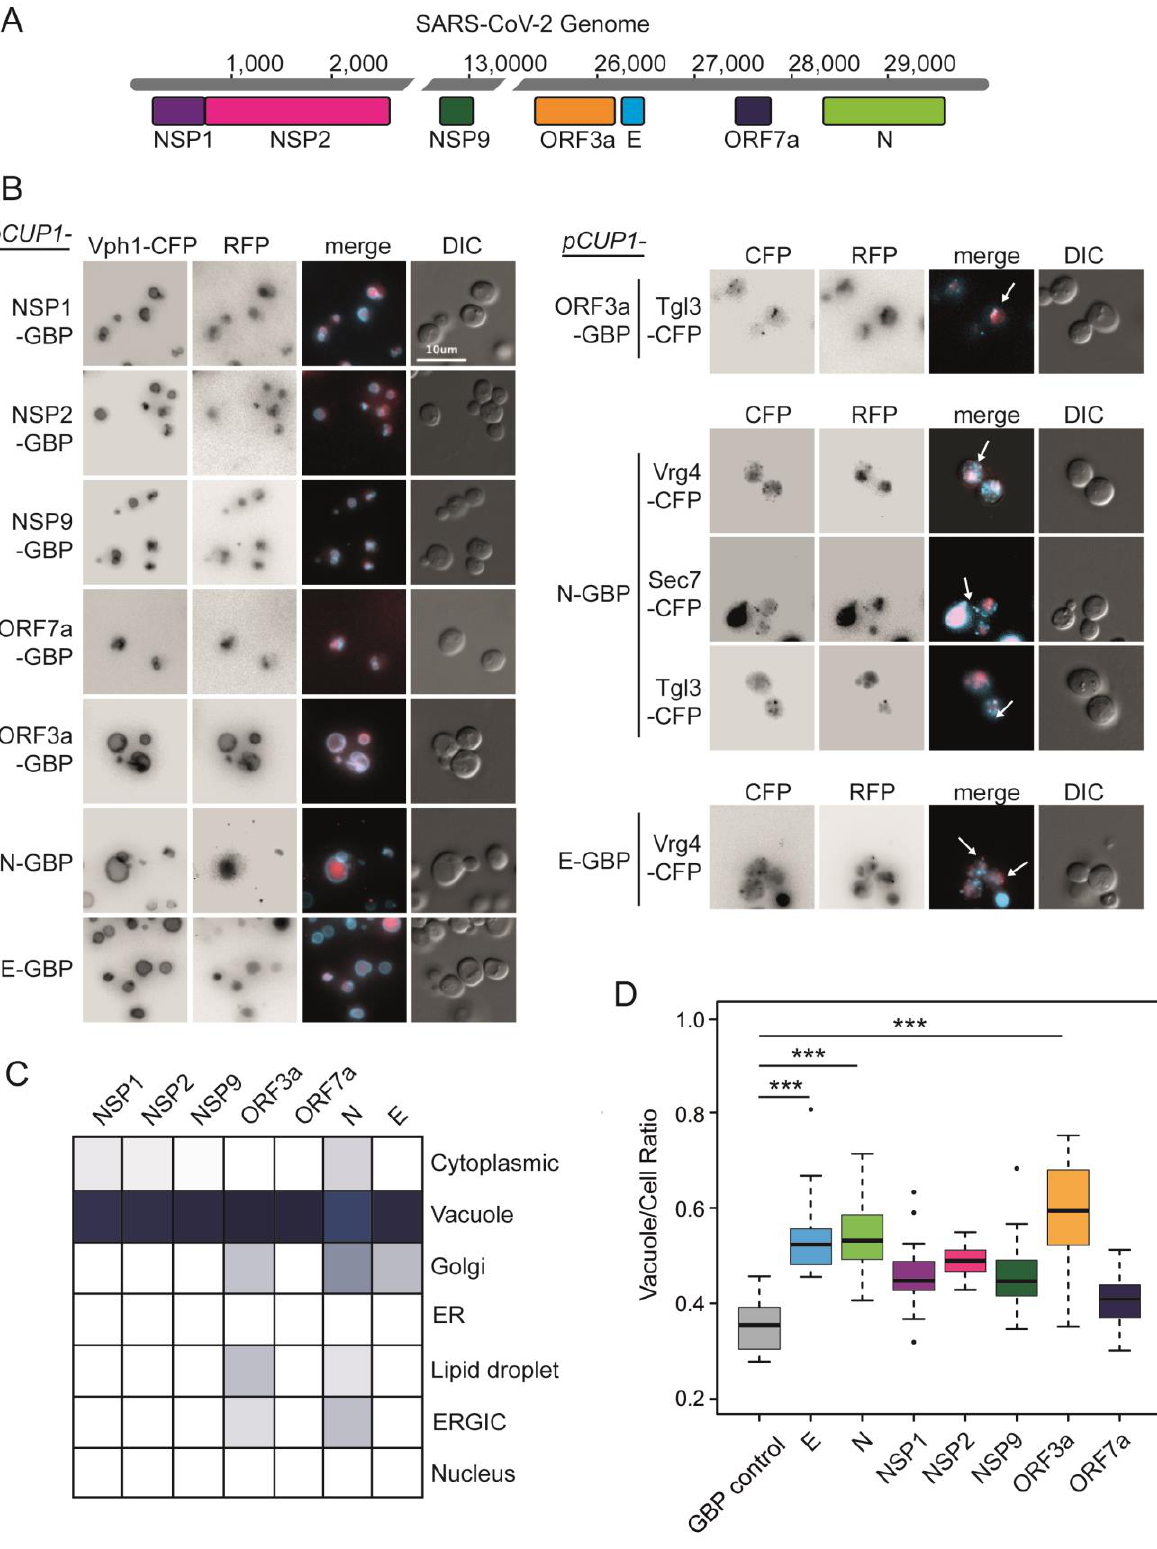
OPEN ACCESS | www.microbialcell.com 282 Microbial Cell | DECEMBER 2021 | Vol. 8 No. 12